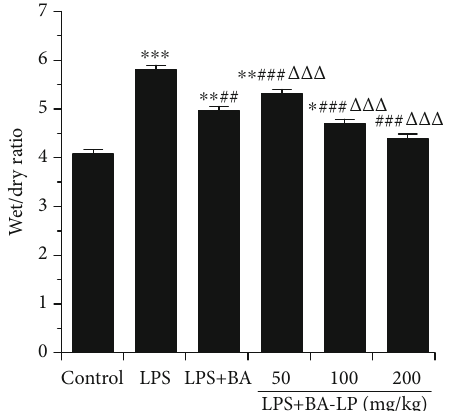
Figure 2: BA alleviates the lung W/D ratio induced by LPS. After 12 h after LPS injection, mice were sacri fi ced to get the lung tissues to analyze the lung wet/dry ratio. The values were presented as means ± SD ( n = 5 ). ∗ P < 0 : 05 , ∗∗ P < 0 : 01 , and ∗∗∗ P < 0 : 001 vs. the control group; ## P < 0 : 01 and ### P < 0 : 001 vs. the LPS group; and △△ P < 0 : 01 and △△△ P < 0 : 001 vs. the LPS+BA